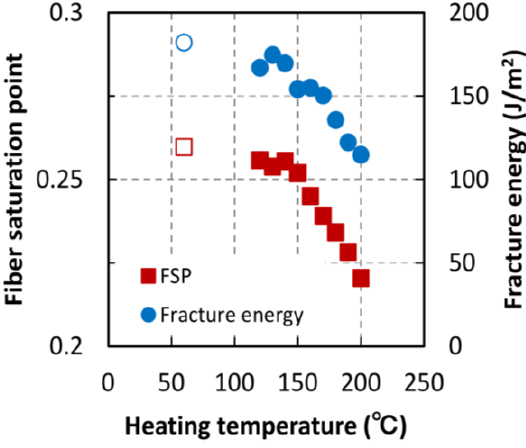
Figure 7. Fiber saturation point values obtained using adsorption isotherm curves. Open symbols indicate the data without heat